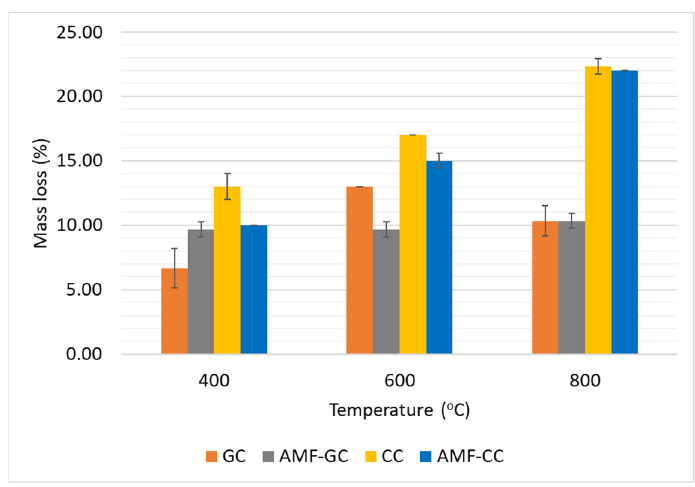
Figure 3. Mass loss of cement and geopolymer composites at elevated